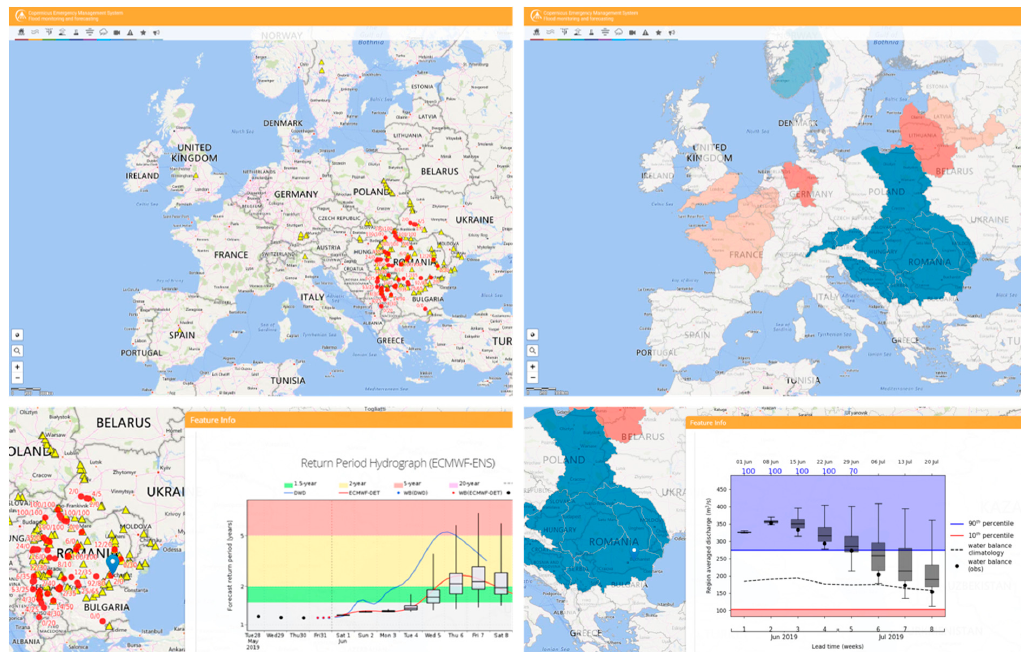
Figure 1. An example of four screenshots from the European Flood Awareness System (EFAS) system at the two forecast horizons: (left) Medium-range (10-day) forecasts showing a map (top) of the reporting points where the system forecasts exceedances of flood thresholds, and (bottom) an example hydrograph forecast at a river location in Romania (10-day forecasts issued on 1 June 2019). (right) The sub-seasonal (eight-week) EFAS outlook (top) showing areas with flows forecasted to be above the 90th percentile (blue) and below the 10th percentile (red) of river climatology, and (bottom) example boxplots of ensemble discharge predictions for a region encompassing parts of Romania, Bulgaria and Serbia (eight-week forecasts issued on 01 June 2019).